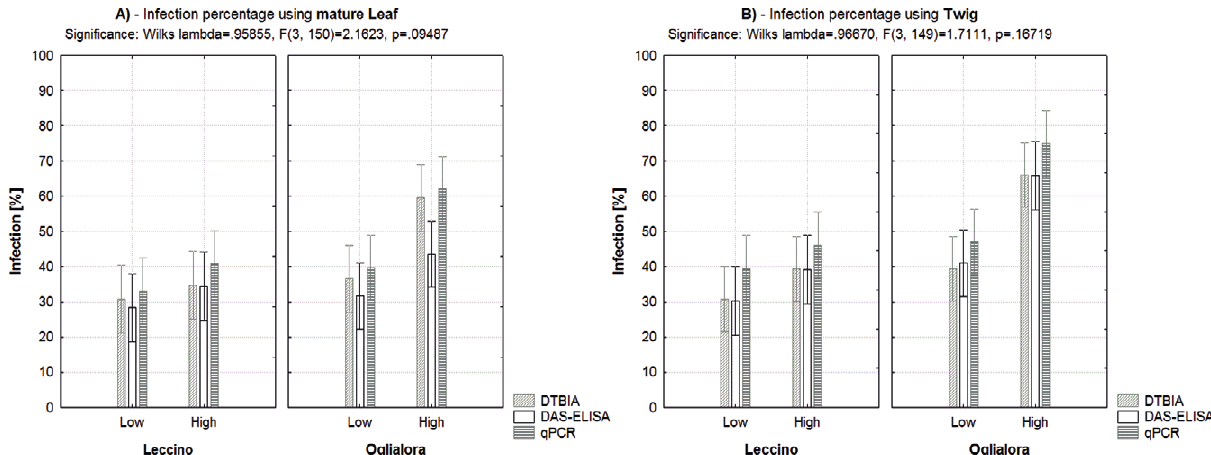
Figure 4. Mean Xylella fastidiosa infection rates in two olive cultivars (‘Ogliarola salentina’ and ‘Leccino’) assessed using xylem tissue from leaves (A) and twigs (B), from two host canopy levels (high, low) and using three diagnostic methods (DAS-ELISA, DTBIA,